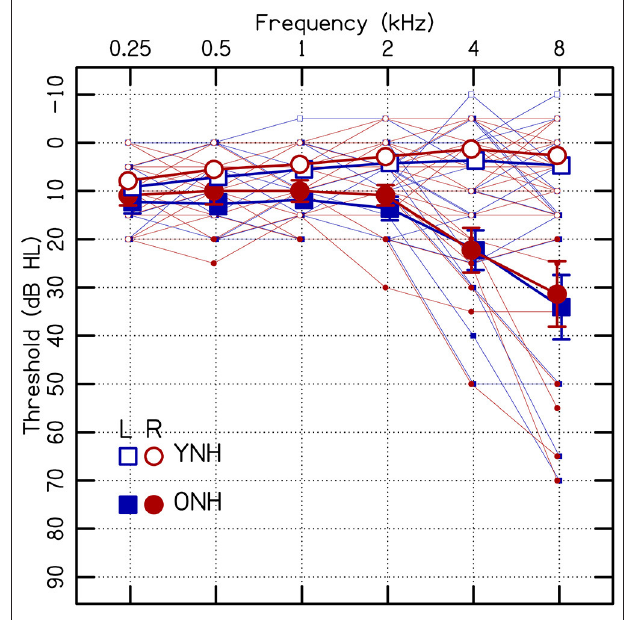
FIGURE 1 | Individual (small points) and average (large points) audiometric thresholds in dB (re: hearing level, HL). Error bars represent ± 1 standard error of the listener mean. Some points have error bars smaller than the size of the point. ONH, older normal hearing; YNH, younger normal